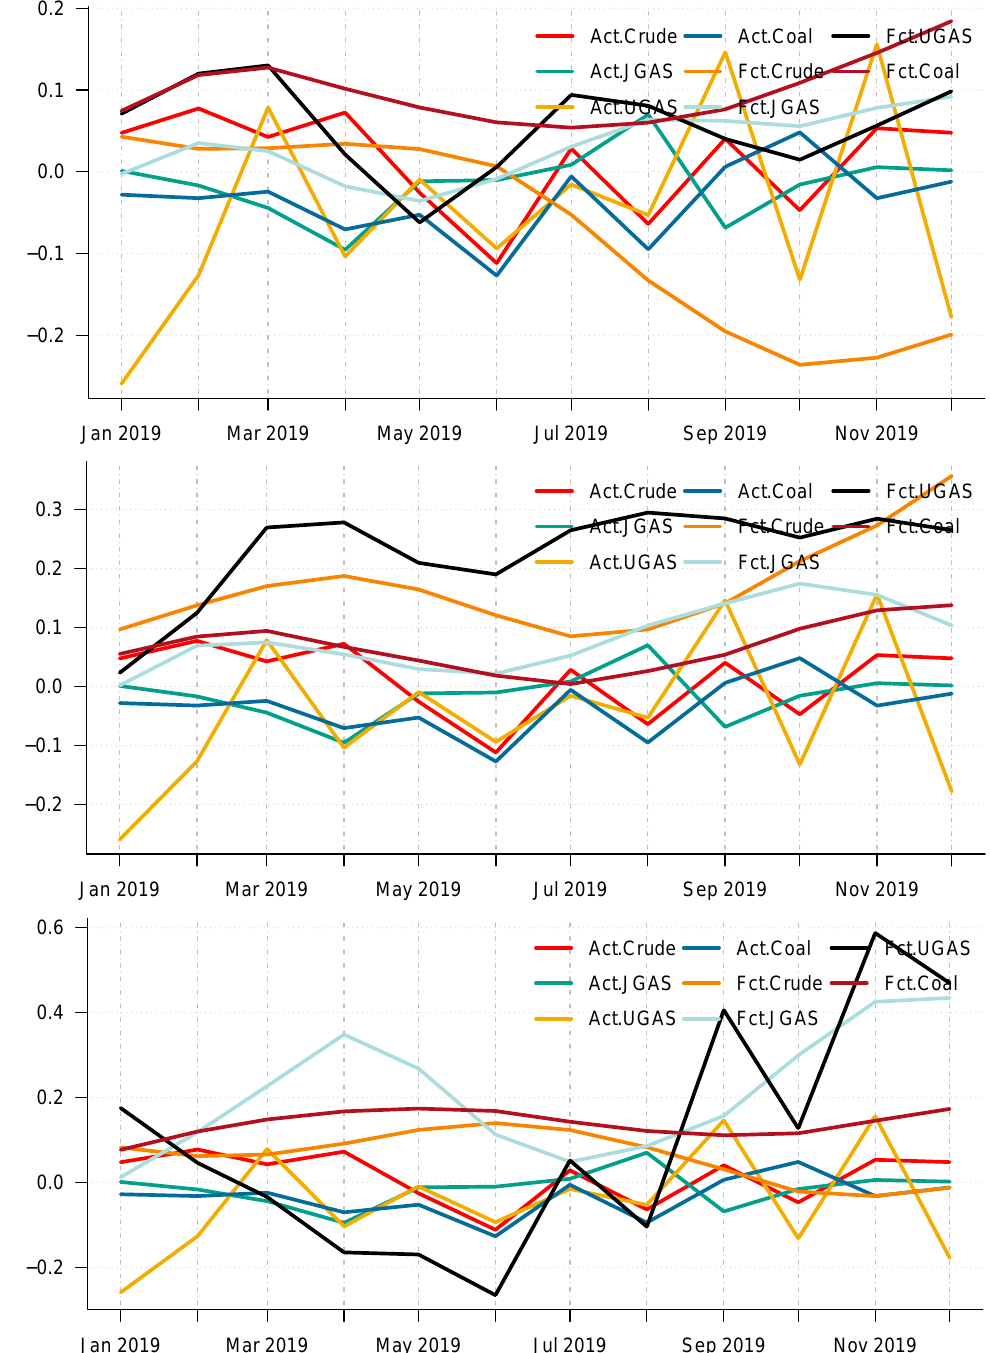
Figure 13. Actual price return series versus price return forecast of (CEEMDAN-ELM, EEMD-ELM, EMD-ELM) hybrid models in 2019. Notably, the abscissa denotes the time in months and the ordinate depicts the forecast errors. ( top ) Panel A: Actual price return series versus price return forecast of crude oil, gas, and coal in 2019 based on CEEMDAN-ELM. It with noting that the abscissa denotes the time in months and the ordinate depicts the forecast errors. ( middle ) Panel B: Actual price return series versus price forecast of crude oil, gas, and coal in 2019 based on EEMD-ELM. Also, here, the abscissa denotes the time in months and the ordinate depicts the forecast errors. ( bottom ) Panel C: Price forecast of crude oil, gas, and coal in 2020 based on EMD-ELM. The x-axis represents time measured in years whilst the y-axis represents the forecast